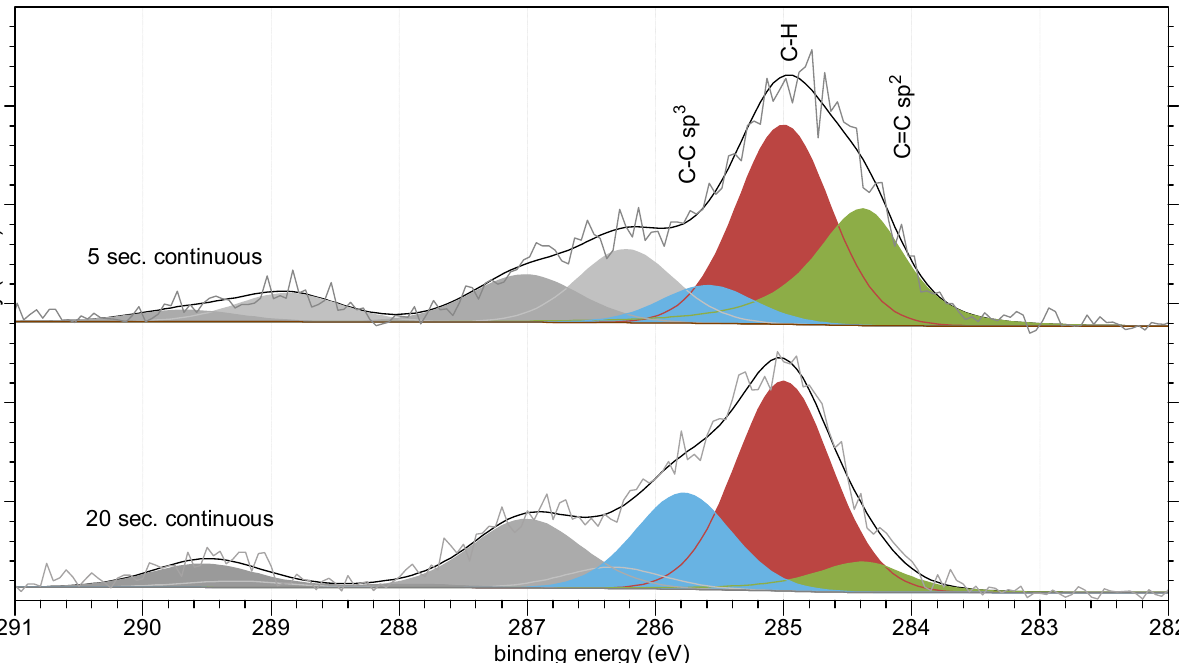
Figure 12. High-resolution XPS spectra of C1s regions: sample “5 s continuous” and “20 s continuous”.